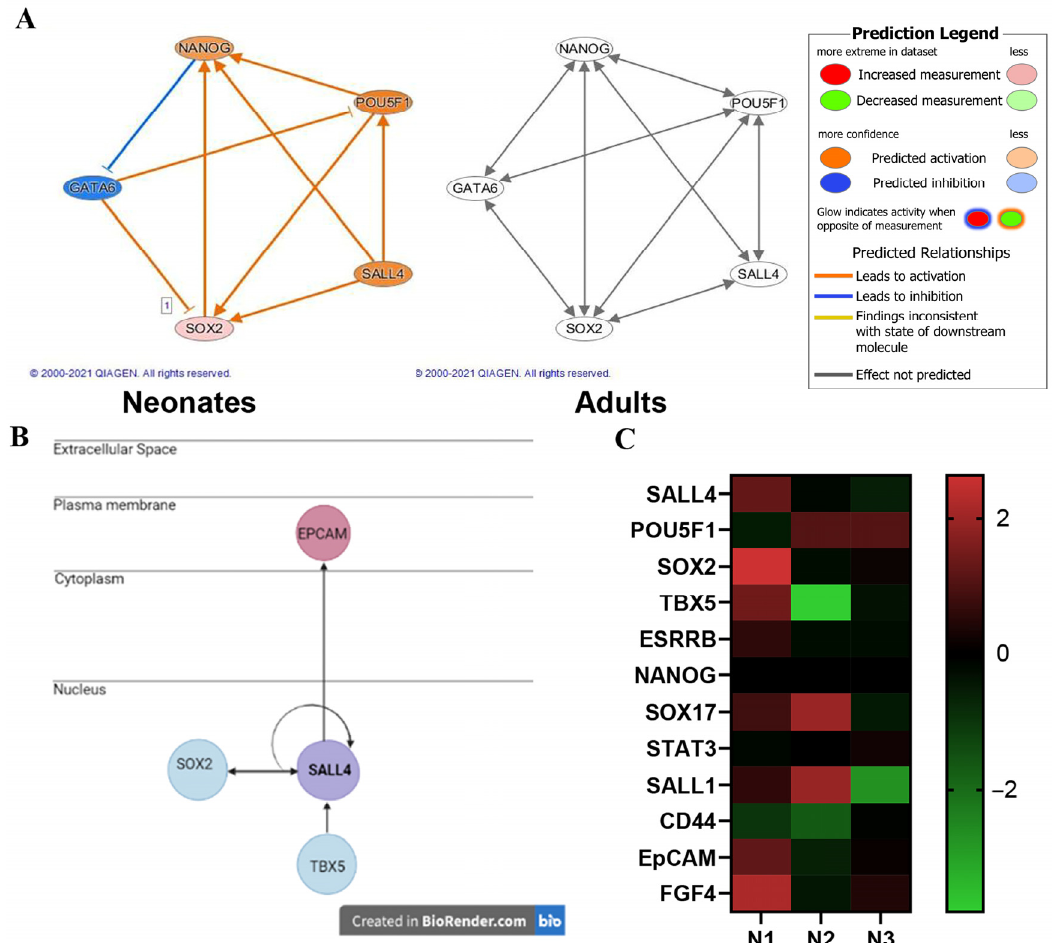
Figure 3. Transcriptomics reveals SALL4 interacts with pluripotency factors in Isl-1+ neonatal CPCs via a mechanistic network of regulators. The predicted activation of a network of genes in neonatal Isl-1+ CPCs (N = 3) ( left ) was not identified in adult Isl-1+ CPCs (N = 3) ( right ) using the IPA tool: molecule activity predictor ( A ). Genes associated with SALL4 ( B ). Heatmap of genes associated with SALL4 that are expressed in three neonatal CPC clones identified as N1, N2 and N3 ( C ).